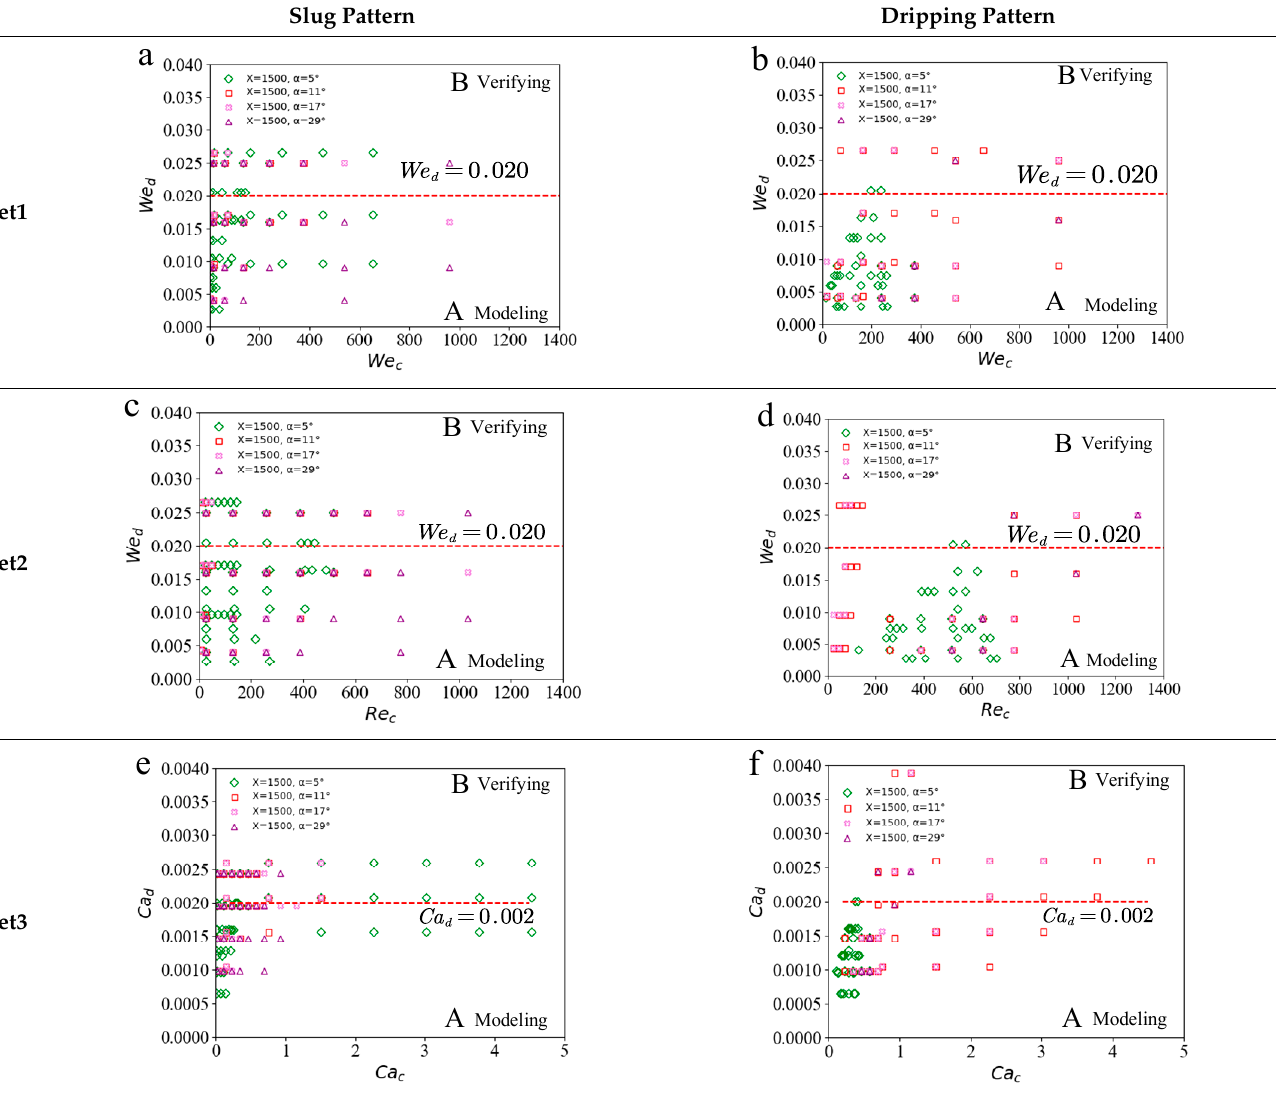
Table 4. Data partition of three sets with dimensionless numbers in Experiment 1: ( a ) slug in Set1, ( b ) dripping in Set1, ( c ) slug in Set2, ( d ) dripping in Set2, ( e ) slug in Set3, and ( f ) dripping in Set3. Slug pattern